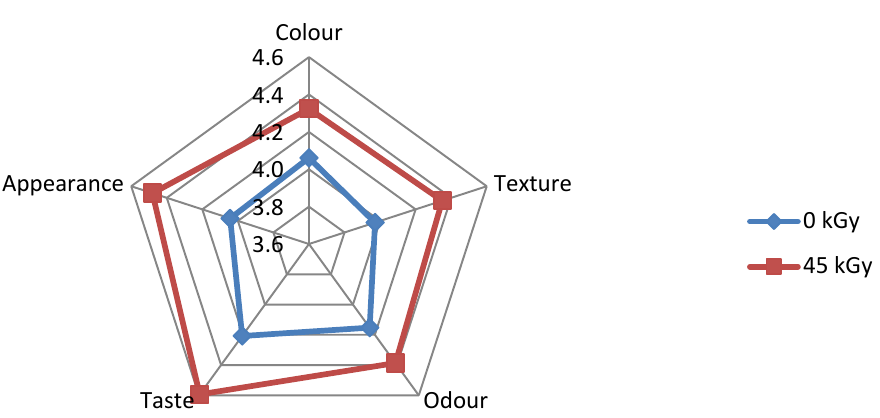
Figure 6. Sensory evaluation of non-irradiated and irradiated semur